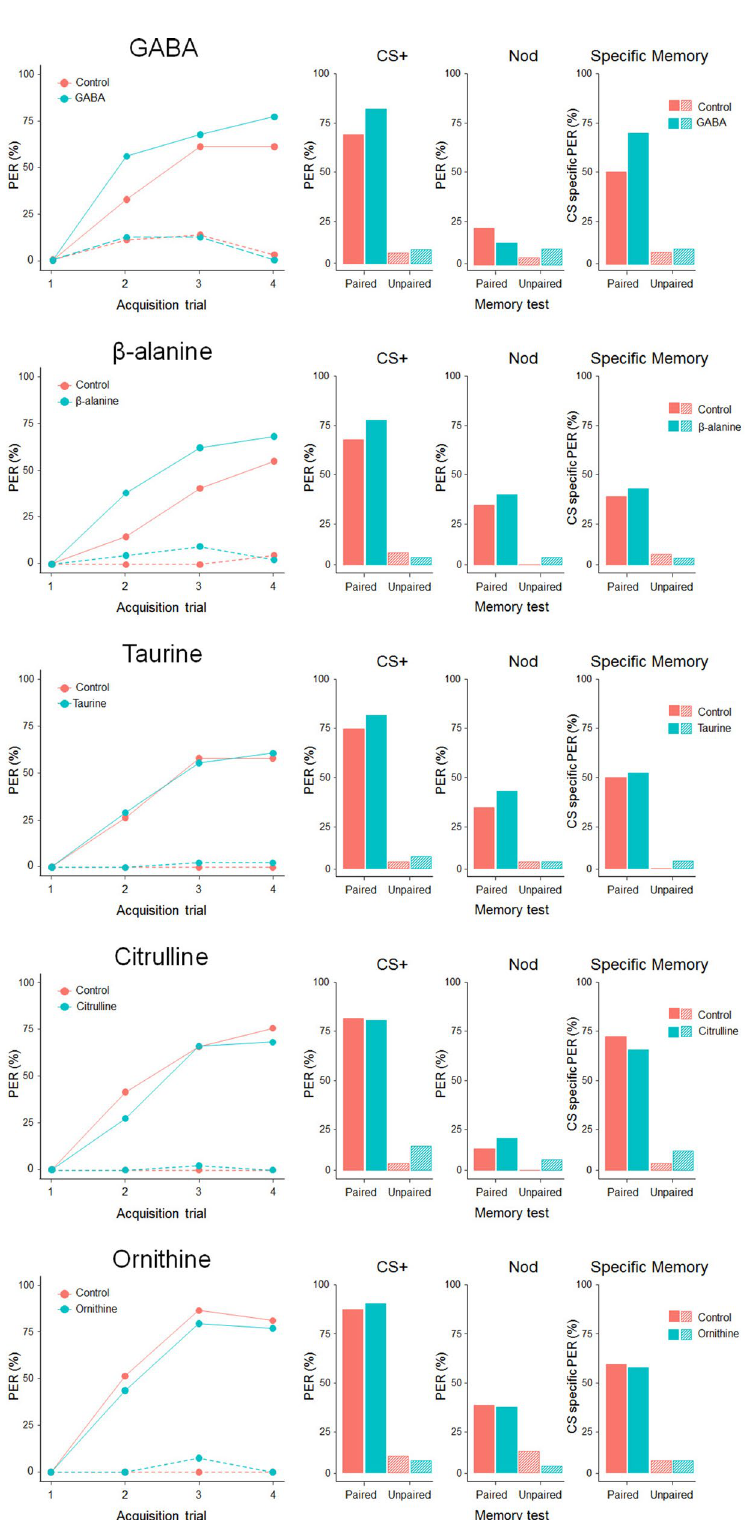
Figure 4. Effects of NPAAs dissolved in US on appetitive olfactory learning and memory retention in harnessed bees. Acquisition trials : Percentages of PER showed by experimental (blue lines) and control (red lines) bees in the paired (solid lines) and unpaired (dotted lines) groups during the contextual conditioning experiment for each of the NPAAs. In the paired groups, GABA and β-alanine significantly enhanced the acquisition performances of bees (GLMM, GABA: p = 0.027; β-ALA: p = 0.009). None of the other NPAAs affected learning performances (all cases: p > 0.4). Unpaired groups did not learn the US-CS association (all cases: p > 0.7). Memory test : Proportions of PER showed by experimental (blue) and control (red) bees in the paired and unpaired groups during the memory test performed two hours after conditioning. GABA significantly enhanced the specific memory of bees for the trained odorant ( χ 2 test, p = 0.03). No difference has been found in the responses to the CS+, to the NOd or in CS−specific memory in all other cases (all cases: p > 0.1). Unpaired groups did not differ in the memory performances (all cases: p >